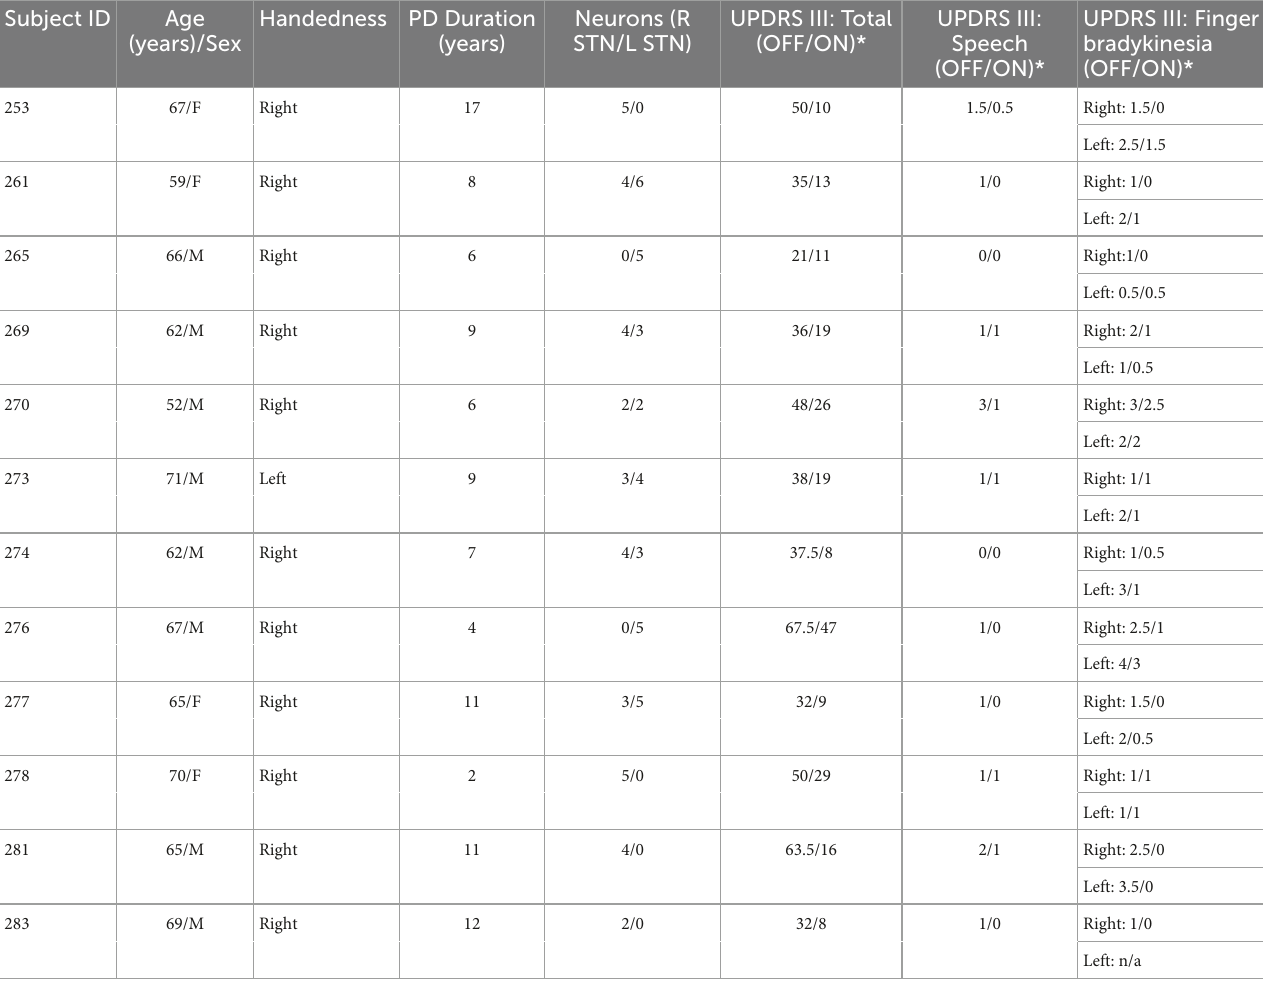
TABLE 1 Demographics and PD characteristics of 12 participants